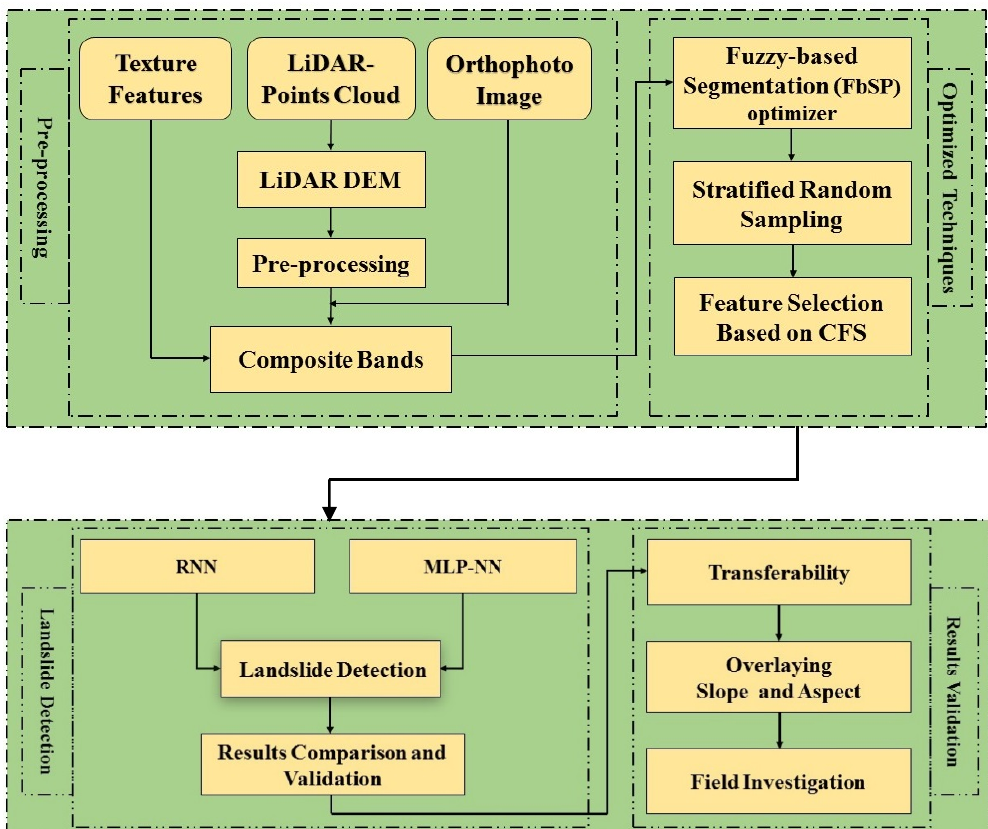
Figure 2. Overview of the proposed method. LiDAR: light detection and ranging; RNN: recurrent neural networks; MLP-NN: multi-layer perceptron neural networks; CFS: correlation-based feature selection; DEM: digital elevation model.